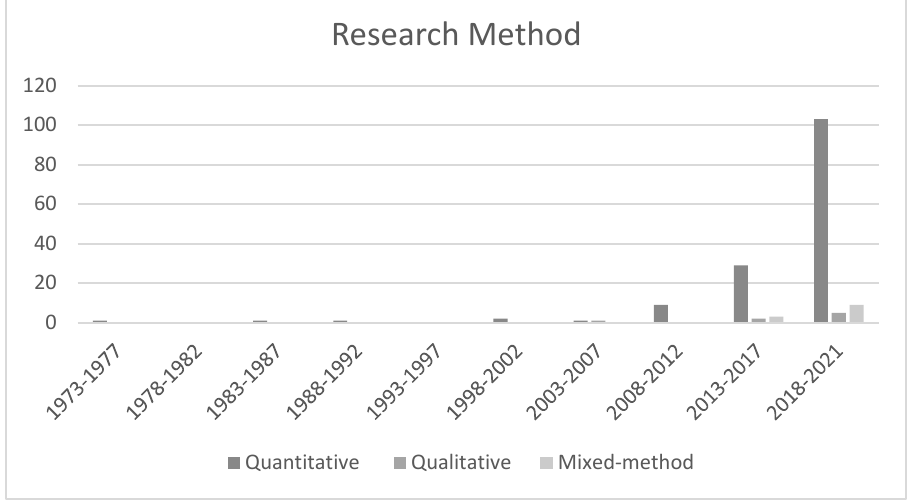
Table 3. Modified Descriptions of Five Statistical Levels from Hallinger (2011). Level